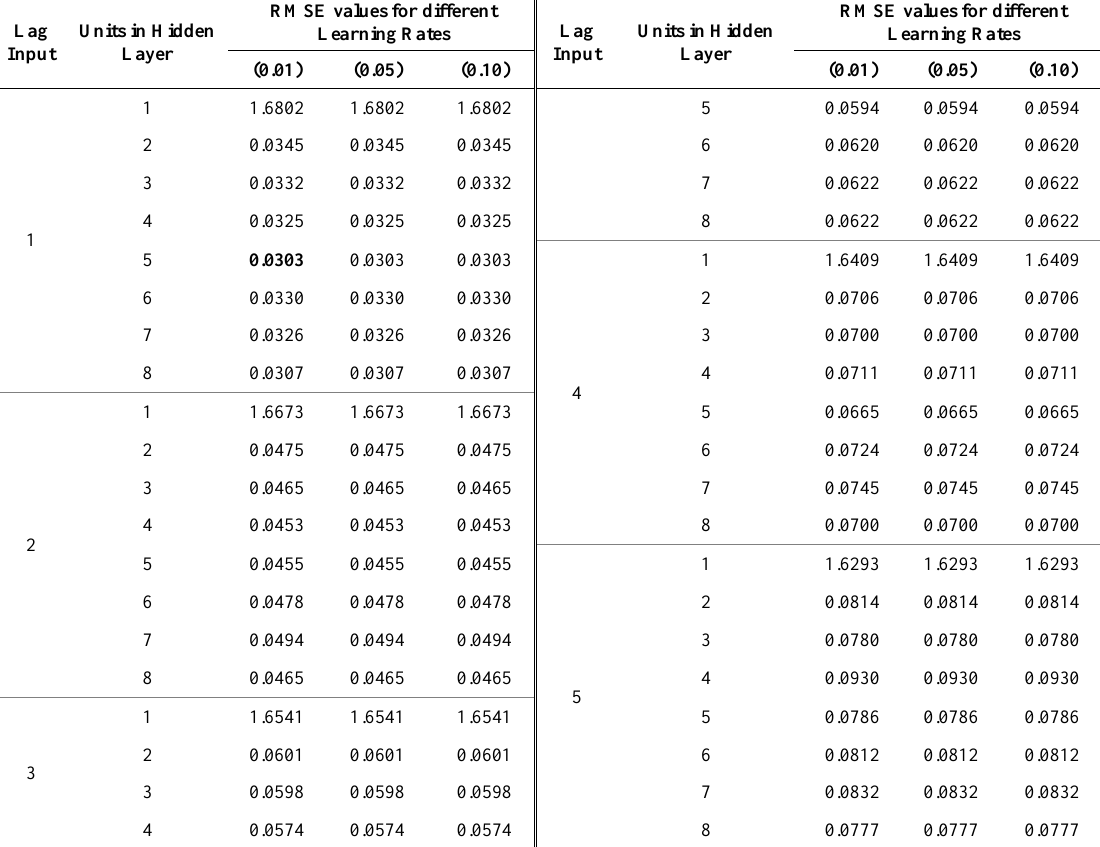
Table 5. The root mean square error (RMSE) values for different neural network models